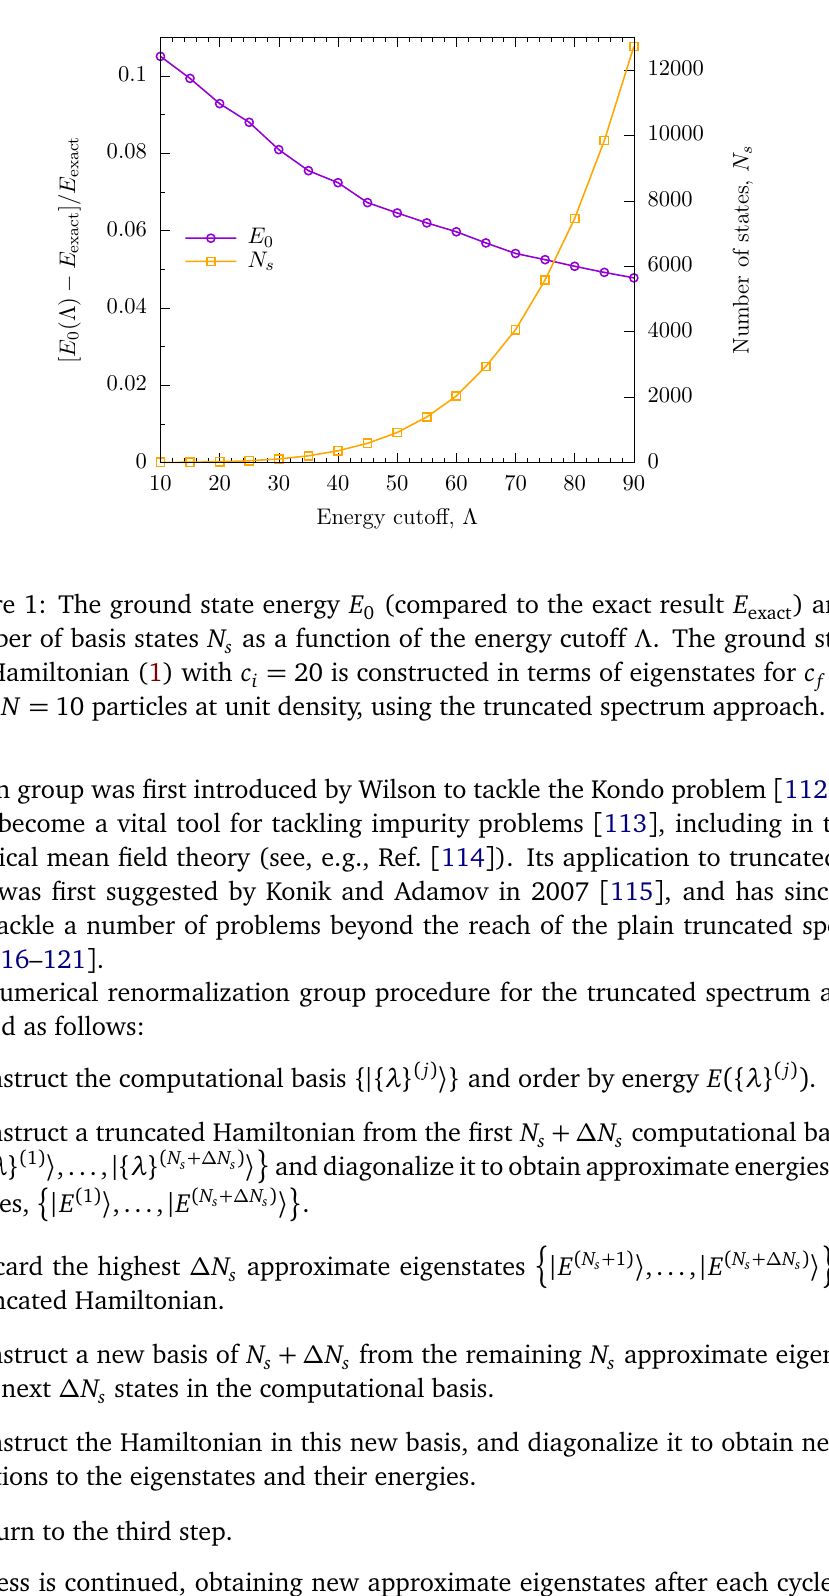
(compared to the exact result E 0 as a function of the energy cutoff Λ . The ground state of s = 20 is constructed in terms of eigenstates for c i